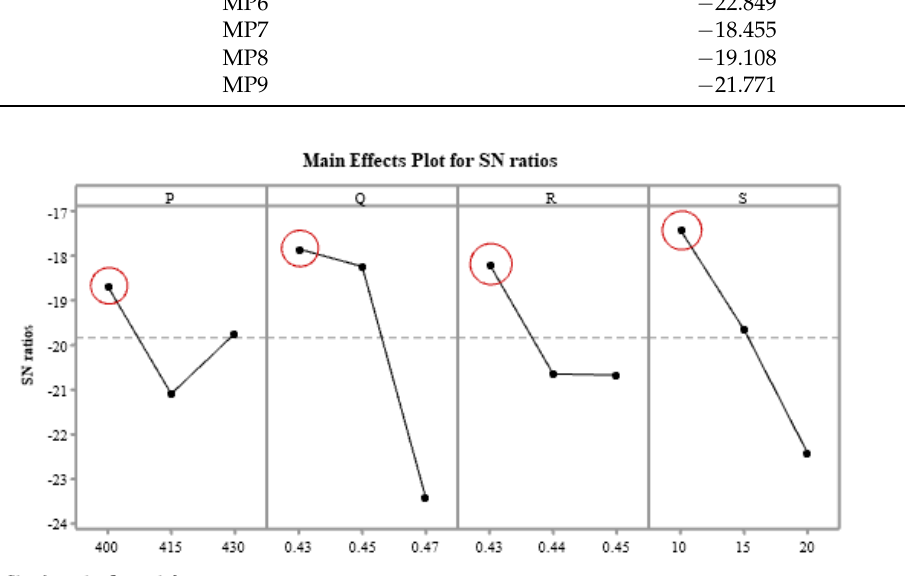
Figure 5. Main effect plot for SN ratios of total weight (the red circle denotes the optimal